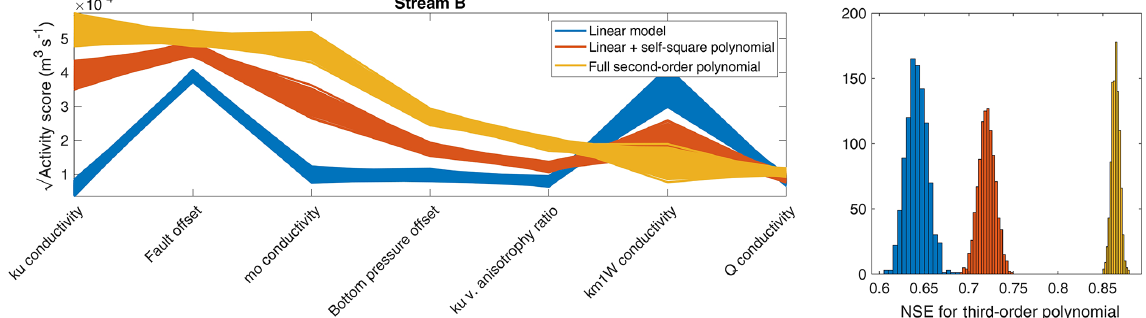
Figure A3. Square root of activity score and corresponding NSE for unwanted flow in stream B (see Fig. 1) using different approximations to compute the gradients.